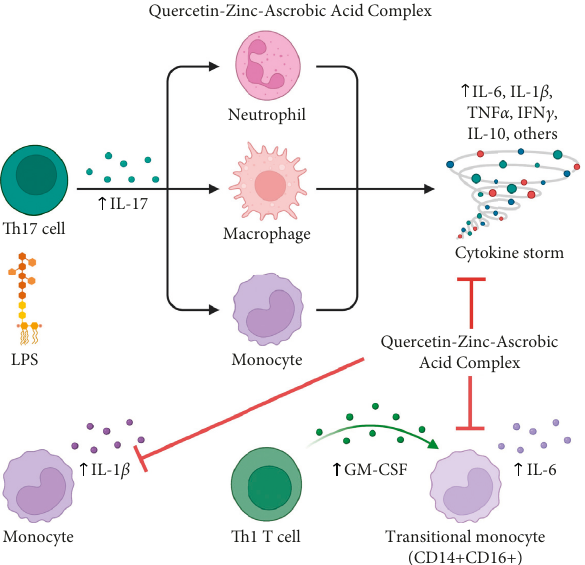
Figure 4: The quercetin complex has a protective effect against tissue damage induced by a cytokine storm in mice. This may be attributed to the quercetin complex being responsible for regu- lating inflammation through downregulating IL-1 and IL-2. This figure was created with the help of